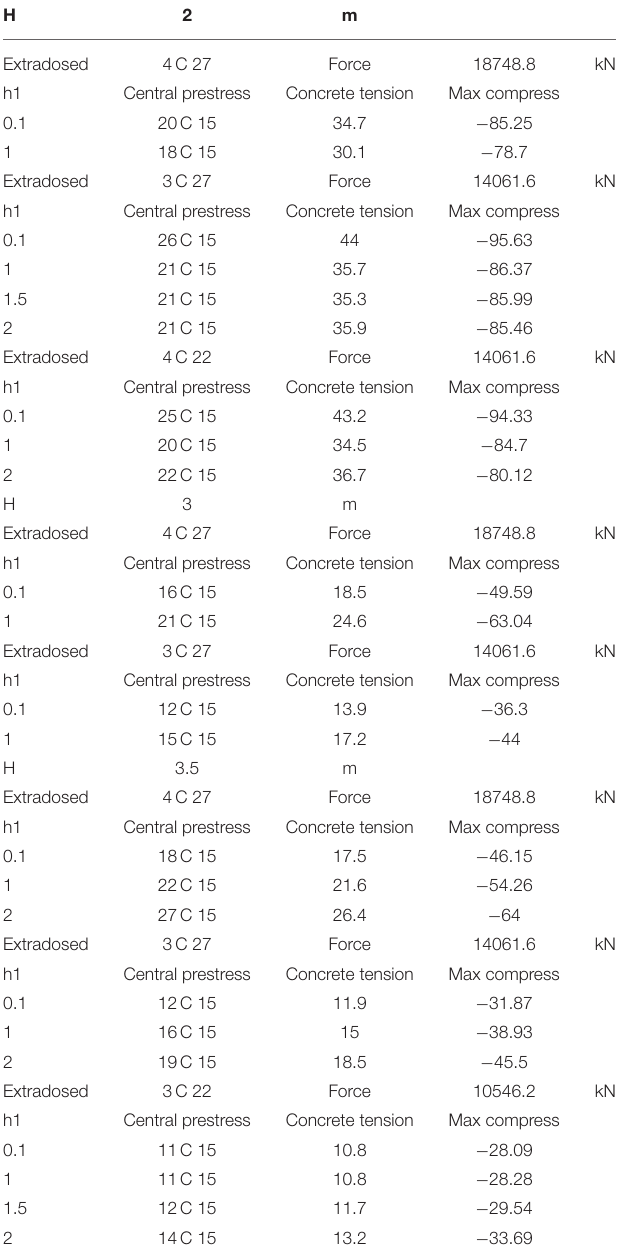
TABLE 1 | Stepwise process to determine the dimensions of the prestressed members and of the cable